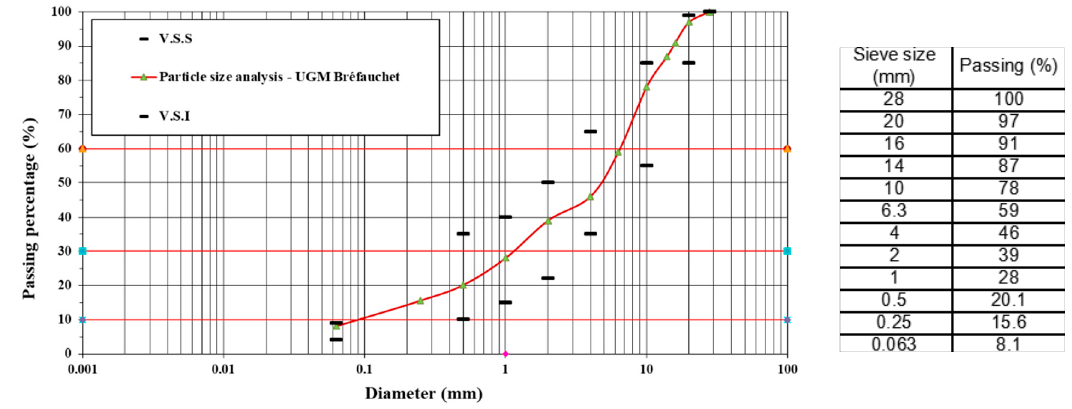
Figure 2. Particle size distribution.